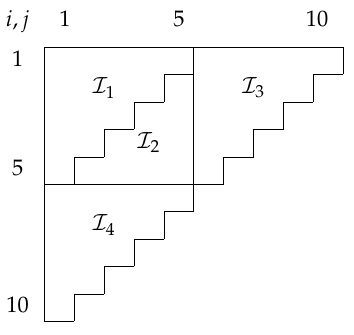
Figure 6. Split of a run-off triangle into four sub-samples as in Harnau